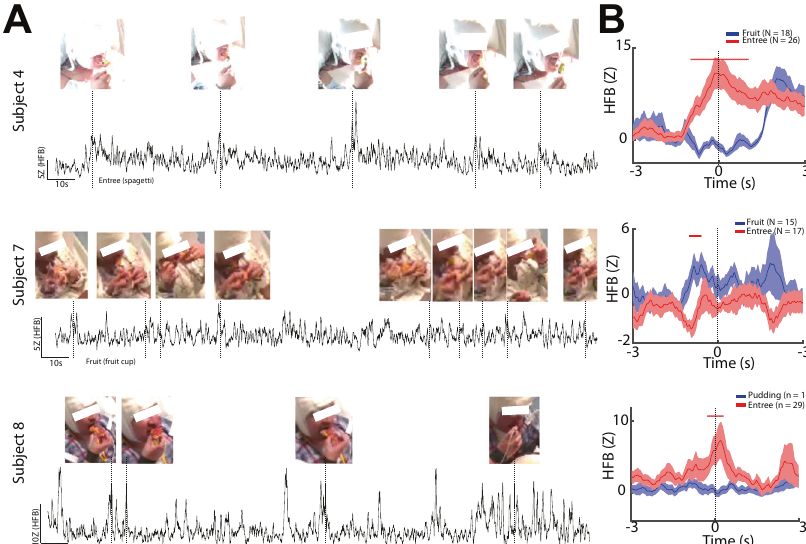
Fig. 5 Time-locked HFB activity during natural eating strati fi ed by type of food consumed. A Simultaneous HFB activity trace and video capture during meal consumption. For each subject, HFB activity computed from spike-minimized data in an exemplar electrode in the left posterior insula is shown. Dotted vertical lines denote the moment food was about to enter the subject ’ s mouth, with accompanying images showing the time point that was used for time-locking. The food being consumed is denoted under the activity trace. B Mean time-locked HFB waveforms strati fi ed by type of food consumed. Dotted vertical lines denote the immediate time point as the food was about to enter the subject ’ s mouth. Time points signi fi cantly different between entrée vs. non-entrée near the time of food entering the mouth ( p < 0.05, cluster-based permutation testing, α < 0.05) are marked in red along the horizontal axis. Error bars show